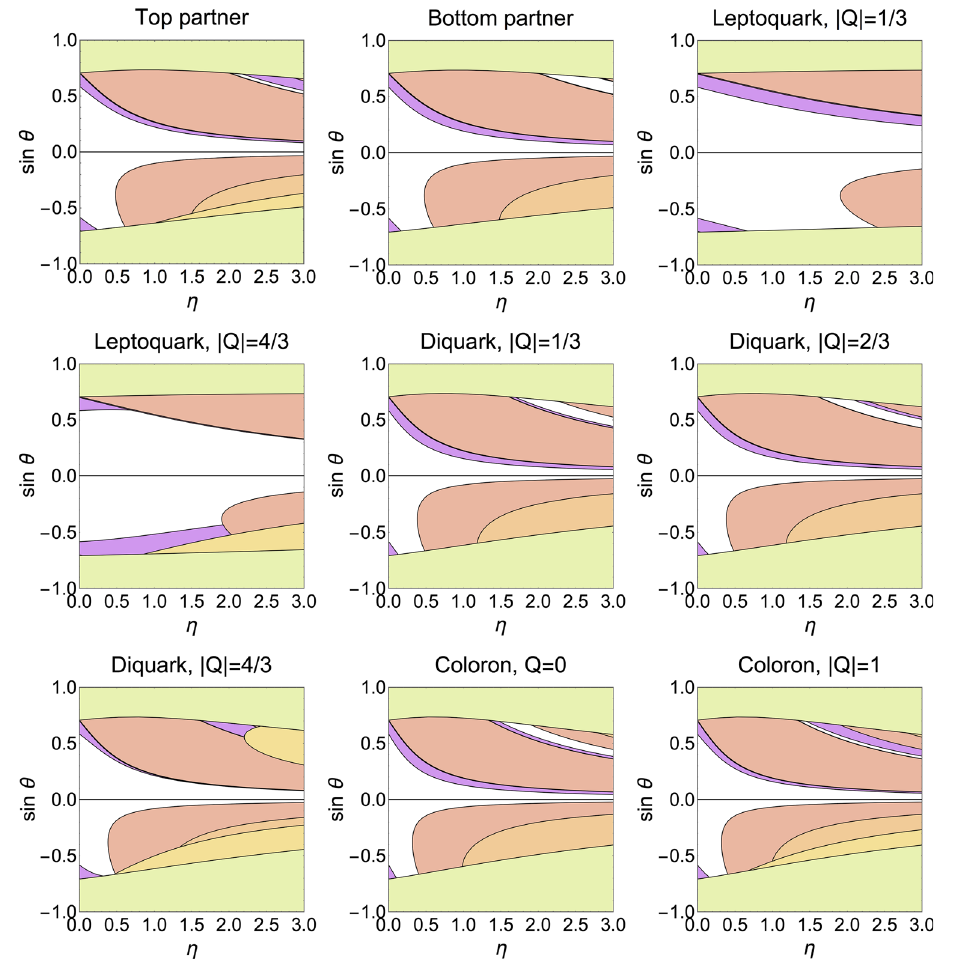
Fig. 4 2 σ -excluded regions from the signal strength of 125GeV Higgs are shaded. The color represents the contribution from each channel; see Fig. 5 for details